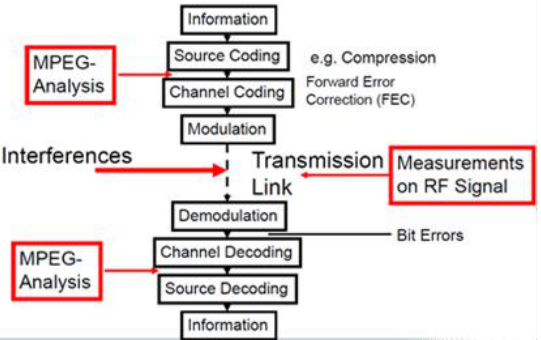
Figure 10. Transmit and receive path of the DVB-T2